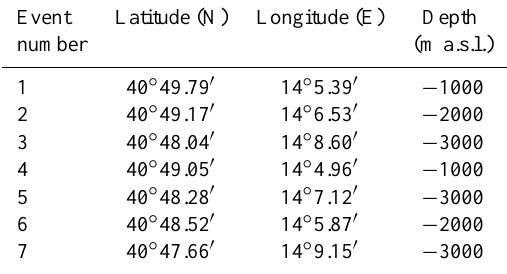
Table 2. Locations of the synthetic hypocenters used in the net- work optimization, earthquakes are indicated with stars in Fig. 3. The synthetic earthquakes have moment magnitude equal to 1.